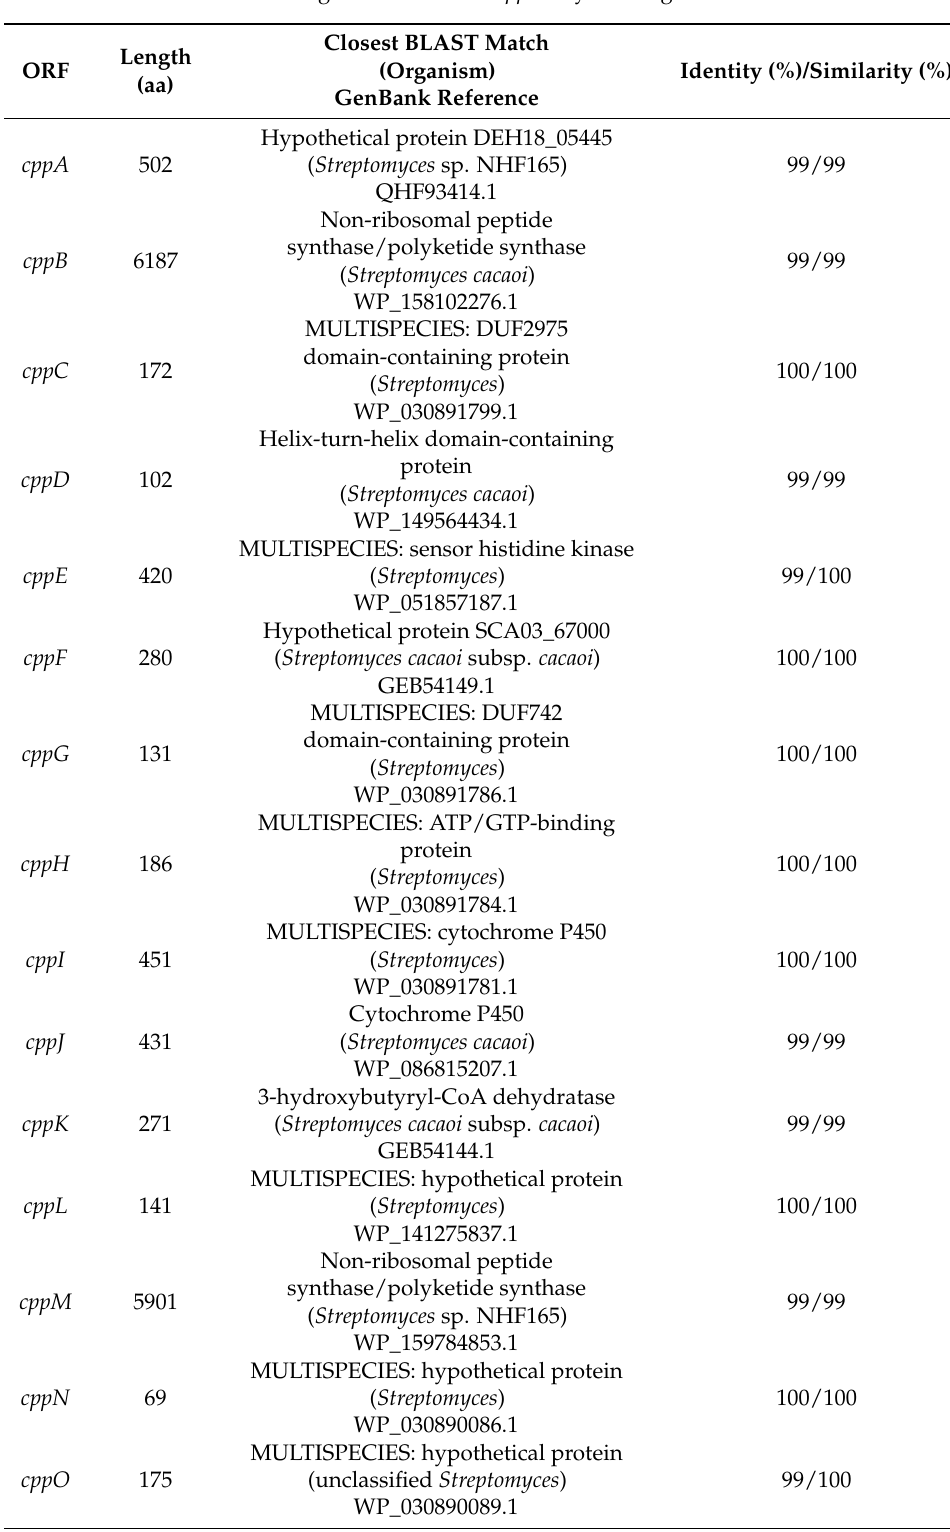
Table 1. Closest BLAST homolog for each ORF in cpp biosynthetic gene